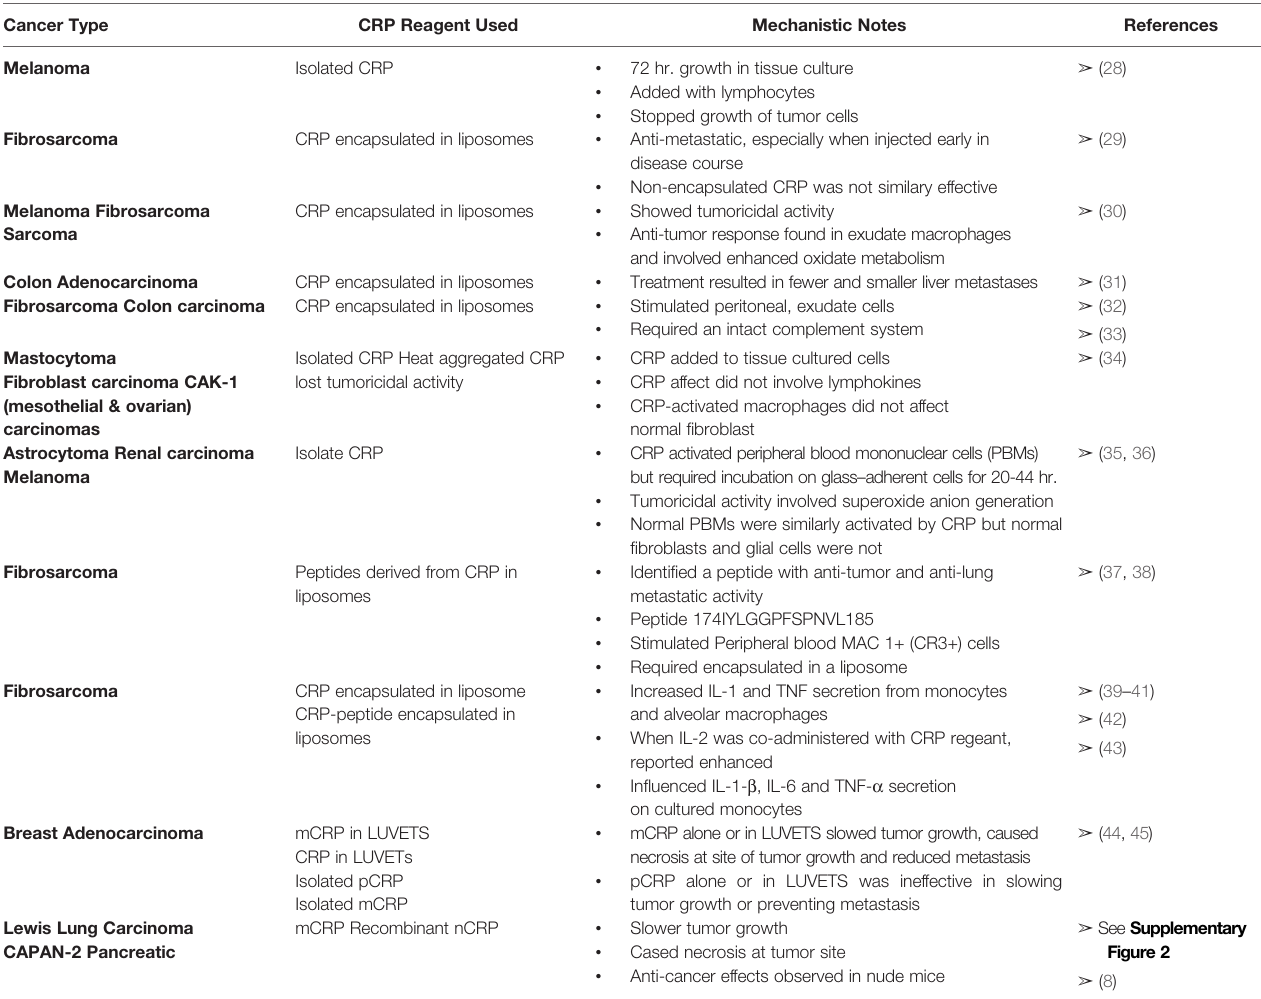
TABLE 2 | Activities of pCRP and mCRP with various Cancer